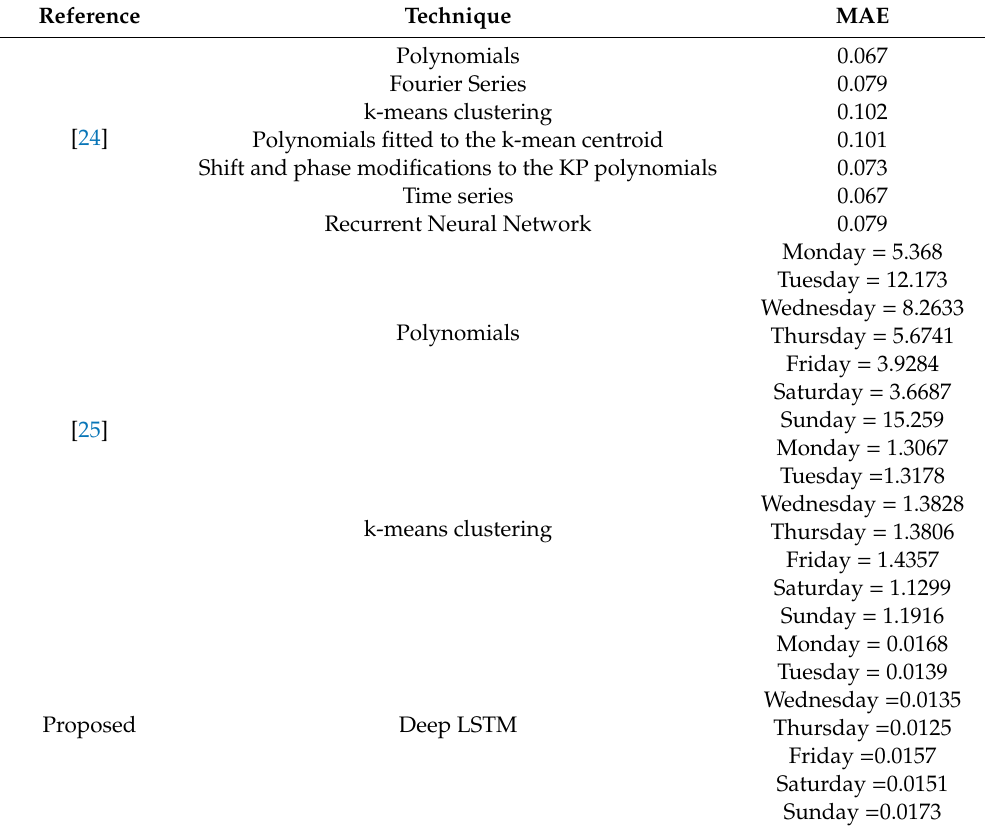
Table 6. Performance (MAE) comparison with other